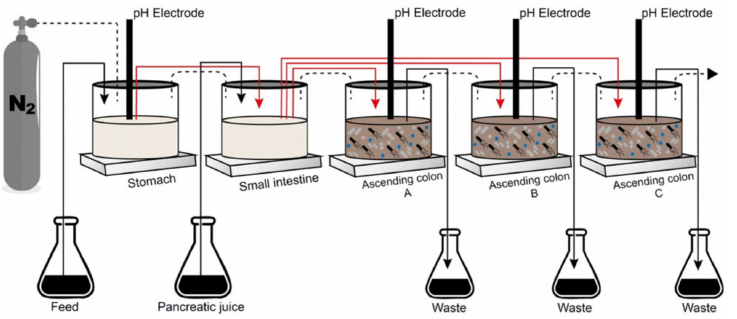
Figure 1. Simulator of the Human Intestinal Microbial Ecosystem (SHIME ® ) adapted adapted with permission from Ribeiro et al.